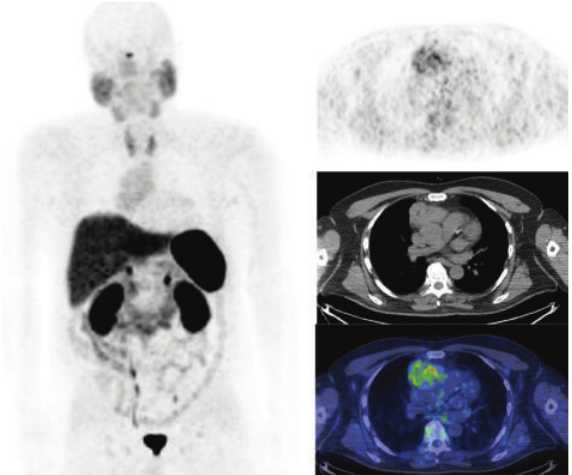
Figure 8: 68 Ga-DOTATATE PET/CT images (MIP, axial) in a patient with